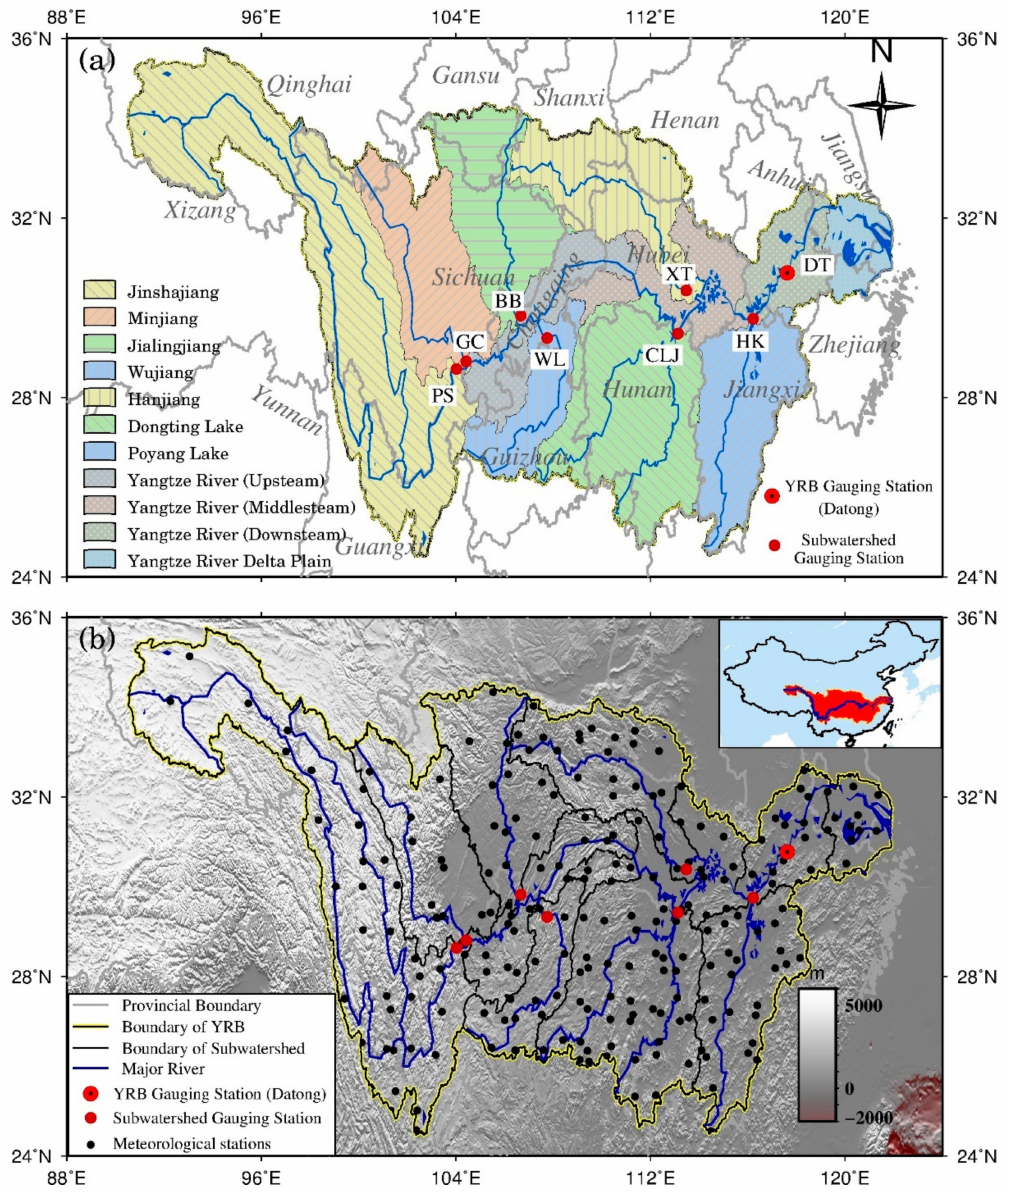
Figure 1. ( a ) Boundaries of the Yangtze River Basin (YRB) and its 11 subwatersheds, and ( b ) YRB topography and the locations of in situ